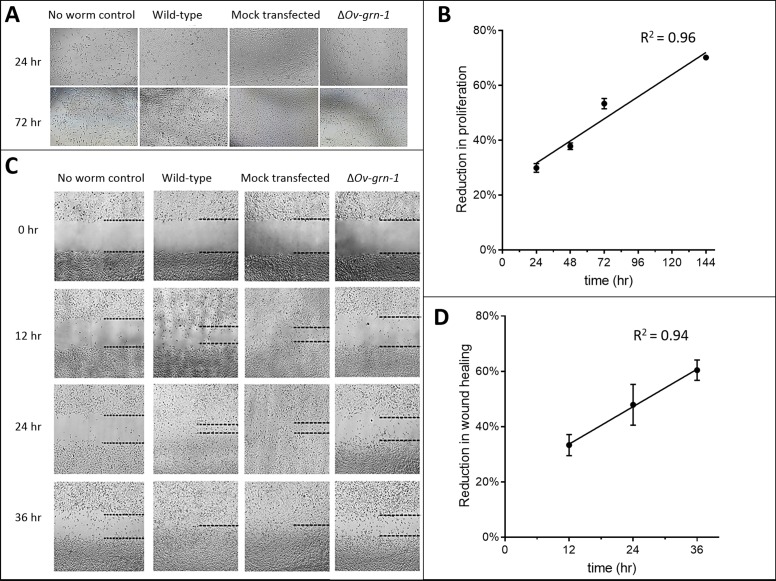
Extended set of images showing ΔOv-GRN-1 adult fluke ES products induce less in vitro cell proliferation and wound repair.(A) Representative cell proliferation images of H69 immortalized human cholangiocyte cell line co-cultured with flukes in Trans-well plates; shown at 24 and 72 hr. (B) Comparing the difference in cell proliferation values from Figure 2B between ES products from the ΔOv-GRN-1 flukes and ES from WT flukes revealed a linear correlation of reduction of cell proliferation that increases over time. (C) Representative image of scratch wound repair of cultured cholangiocytes when H69 cells were co-cultured in Trans-well plates with flukes; time points from 0 to 36 hr post-scratch. Dotted line indicates the margin of the wound. (D) Scratch wound repair assay quantified values from Figure 2D showed an increasing linear correlation over time of reduced wound closure when plotting the difference between the ΔOv-GRN-1 and the WT fluke groups. Panels (B) and (D): mean ±SD, three biological replicates.